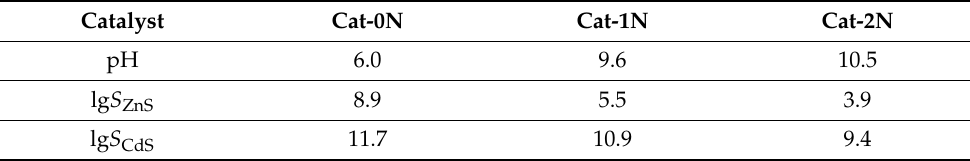
Table 3. The initial pH of the solution of metal complexes before addition of Na 2 S reagent, and the initial supersaturation ( c/c* ) at the beginning of